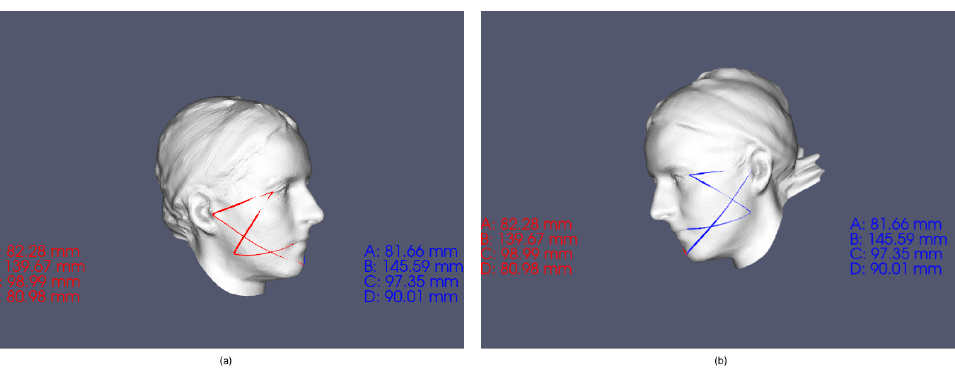
left and right side of the subject’s face. Each letter marks demarcation lines, as defined in Figure 2.